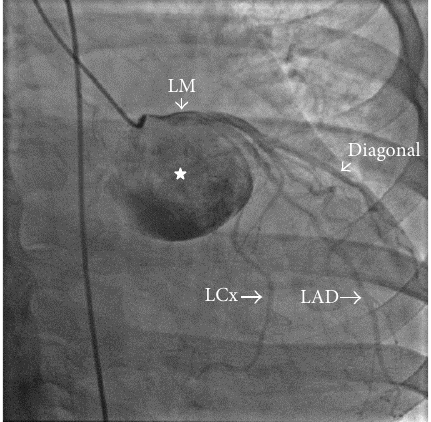
Figure 3: Coronary angiogram shows contrast filling the enlarged left sinus of Valsalva (asterisk). LM: left main coronary artery, LAD: left anterior descending artery, and LCx: left circumflex